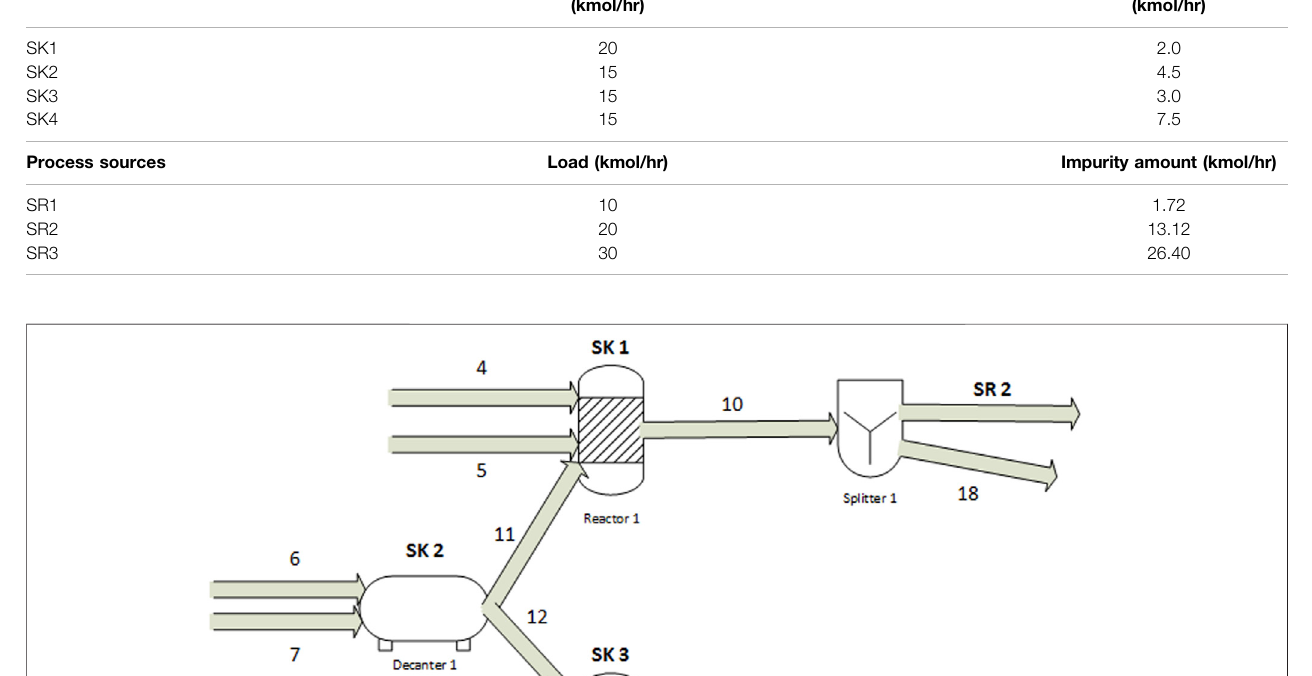
TABLE 4 | Characteristics of process sinks and sources of the case study-2. Process sinks